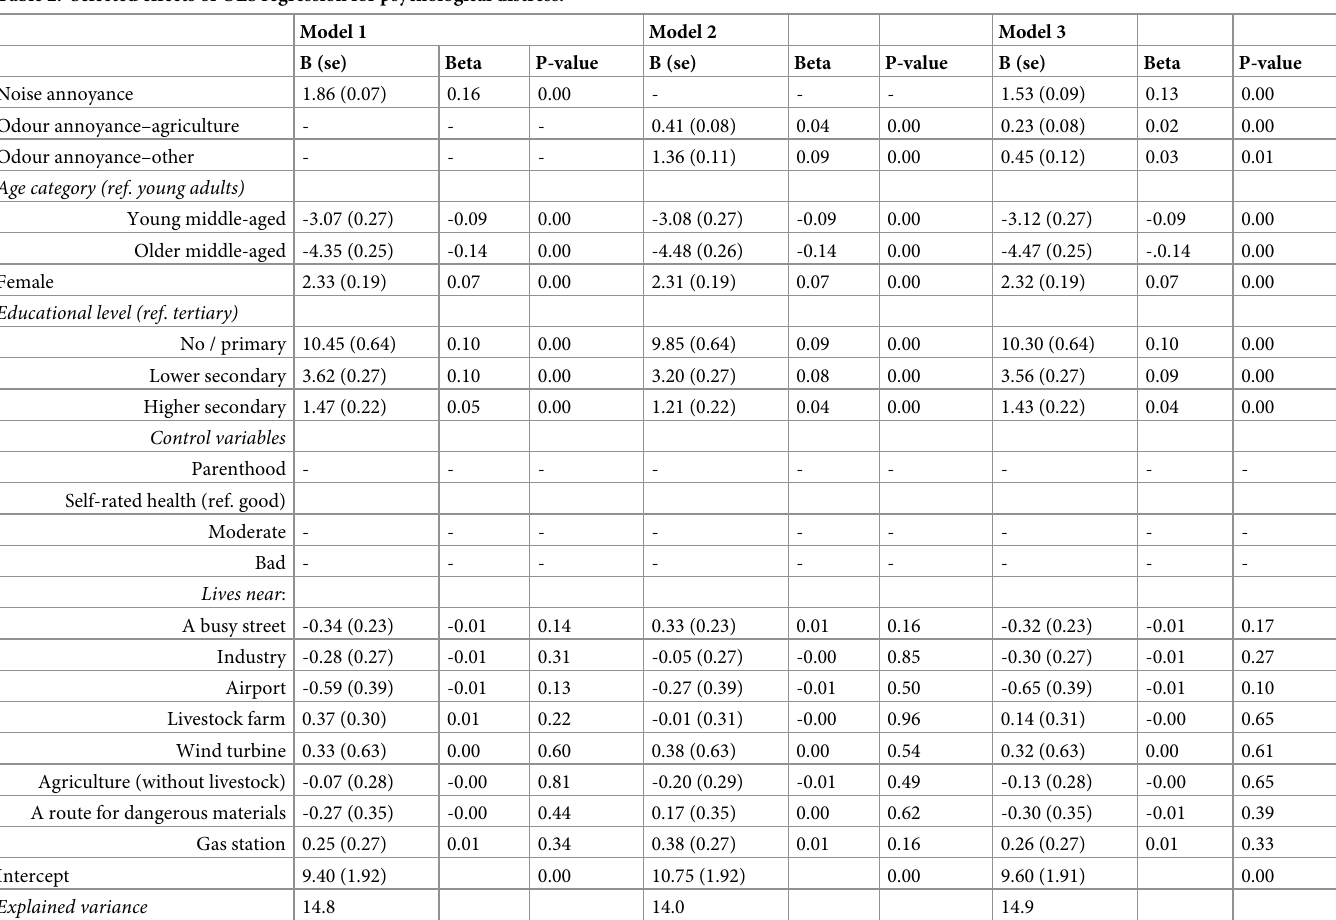
Table 2. Selected effects of OLS regression for psychological